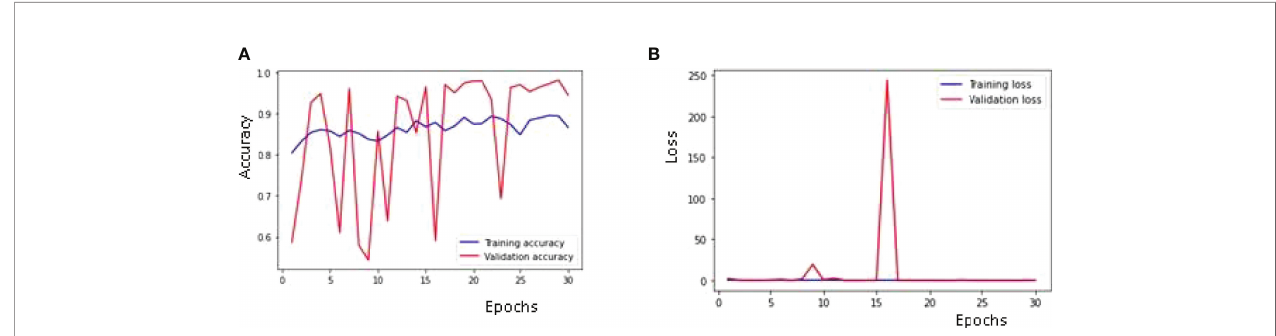
FIGURE 9 | Training and Validation Curves using Adam Optimizer: (A) Accuracy, (B)